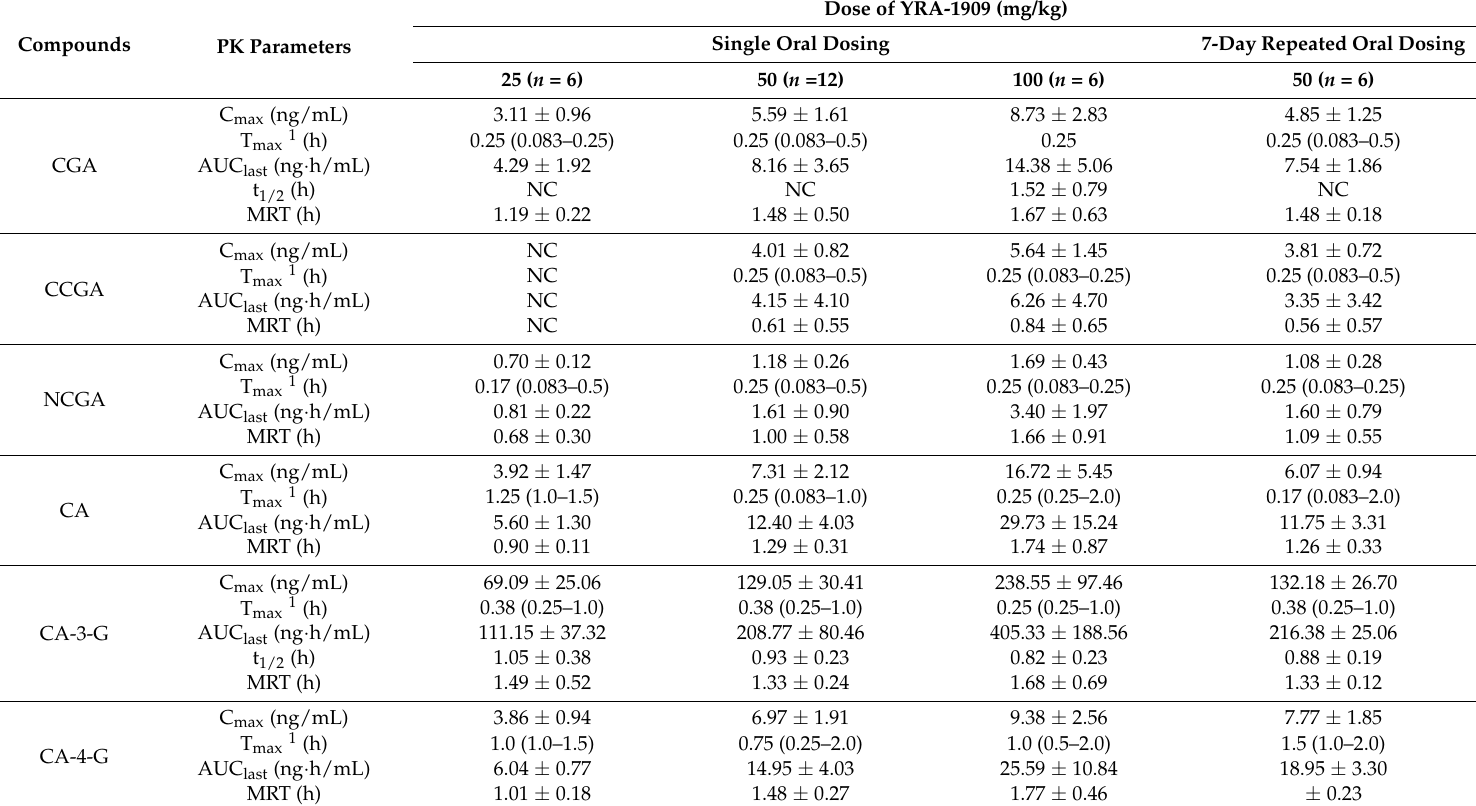
Table 4. Pharmacokinetic parameters of CGA, CCGA, NCGA, CA, CA-3-G, and CA-4-G after a single oral administration of YRA-1909 at doses of 25, 50, and 100 mg/kg (equivalent to 1.2, 2.4, and 4.8 mg/kg CGA; 0.275, 0.55, and 1.10 mg/kg NCGA; 0.87, 1.74 and 3.48 mg/kg CCGA) and repeated administration of 50 mg/kg YRA-1909 for seven days to male rats (mean ±